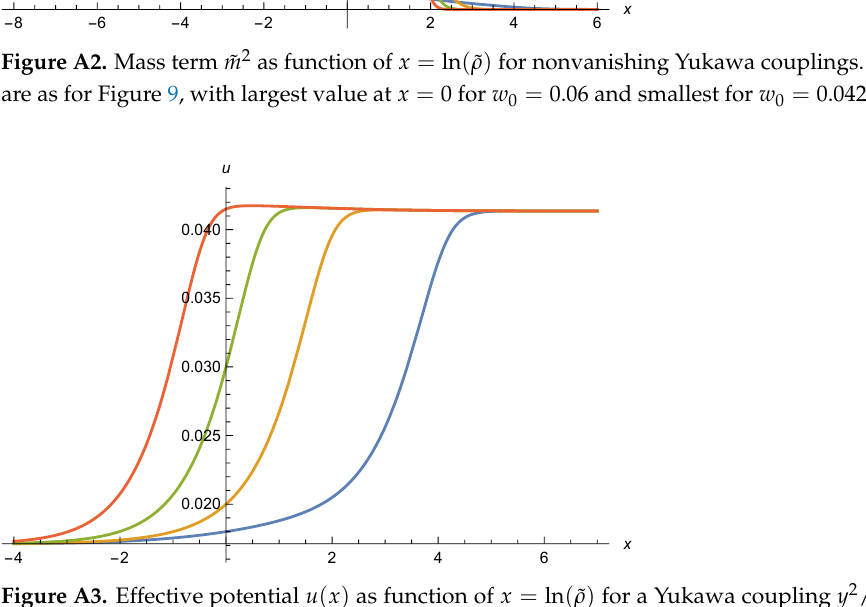
Figure A3. Effective potential u ( x ) as function of x = ln ( ˜ ρ ) for a Yukawa coupling y 2 /4 π = 1/40. Parameters are N = 10, ¯ N f = 1, w 0 = 0.05 and we show different initial conditions at x = 0, namely u ( x = 0 ) = 0.018, 0.02, 0.03, and 0.0415 from right to